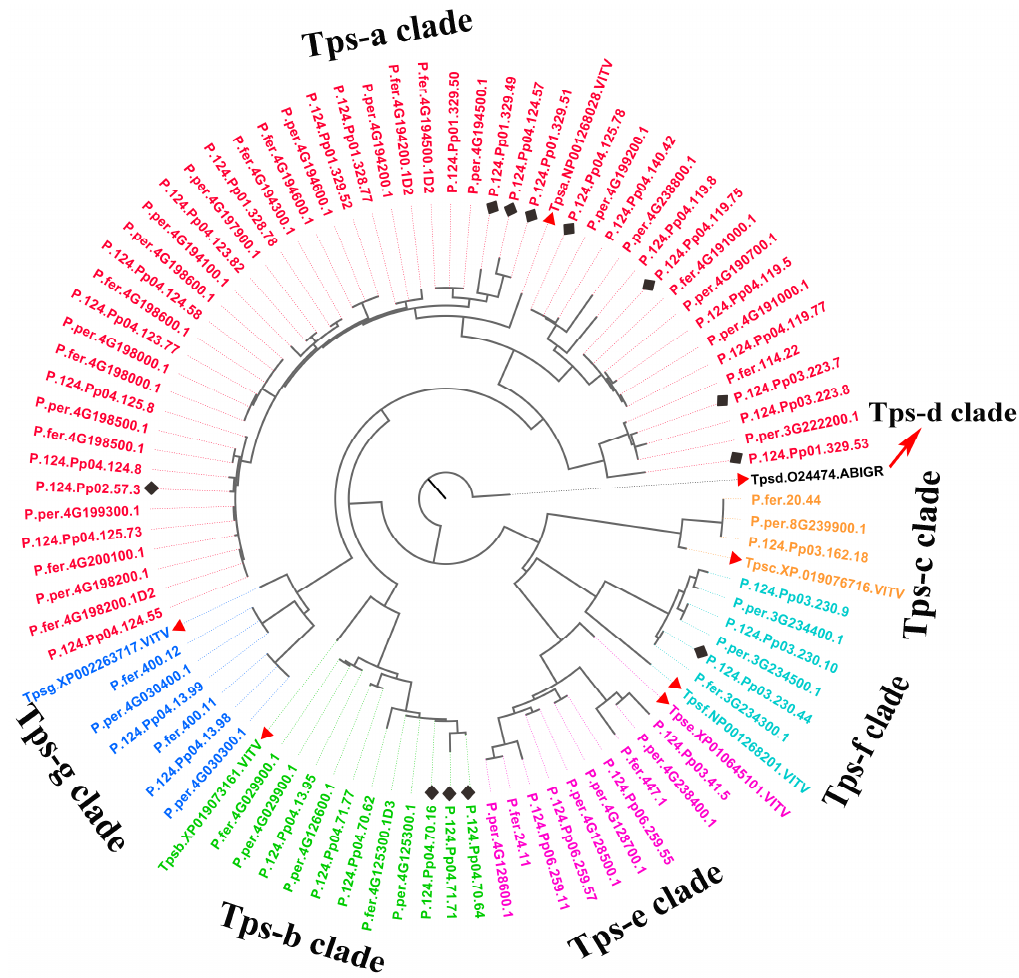
Figure 6. Phylogenetic tree of the TPSs family from ‘124 Pan’ and representative plants. The clades are represented by different colors. The red triangles and black diamonds on some nodes represent the representative sequences of TPS a–g and genes expanded in ‘124 pan’ respectively. The protein sequences of the seven representative TPS a–g proteins are as follows: Tpsa.NP001268028 (valencene synthase-like, Vitis vinifera ), Tpsb.XP019073161 ((-)-alpha-terpineol synthase, Vitis vinifera ), Tpsc.XP019076716 (ent-copalyl diphosphate synthase, Vitis vinifera ), Tpsd_O24474 ( Myrcene synthase, Abies grandis ), Tpse.XP010645101 (ent-kaur-16-ene synthase, Vitis vinifera ), Tpsf.NP001268201 ((E,E)-geranyllinalool synthase-like, Vitis vinifera ), Tpsg.XP002263717 ((3S,6E)-nerolidol synthase 1, Vitis vinifera